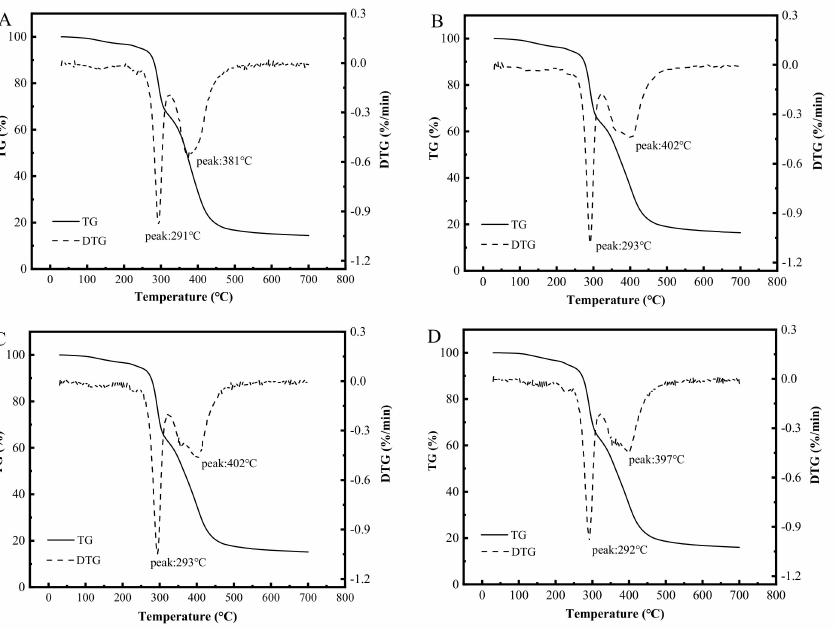
Figure 3. Effect of added proteins on the thermal parameters of crust. ( A – D ) represent the control (without protein added to the batter), soy protein, egg white protein, and whey protein, respectively. The TG and DTG curves represent the correlation between weight change and temperature, and between the rate of weight change and temperature,